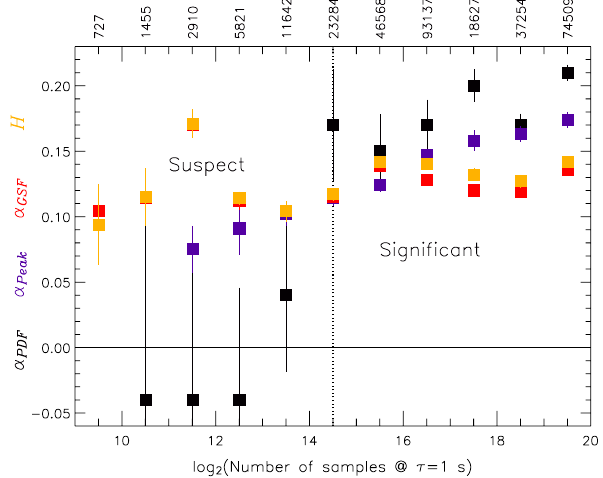
Fig. 11. Estimates of the scaling exponents using all techniques and their 1 σ errors versus log 2 N where N is the number of δ v los samples at τ =1s and all MLT. Only the first N samples were used as N was decreased by the same amount at all τ . The vertical dotted line at N =23284 samples signifies the nominal number of samples required to obtain reliable